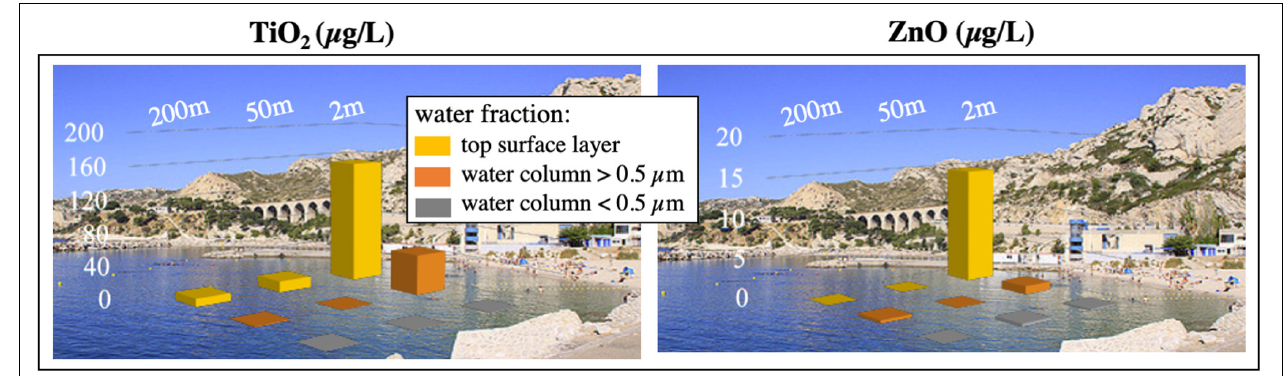
FIGURE 4 | TiO 2 and ZnO concentrations calculated from Ti and Zn elements measurements in marine beach water on the French Mediterranean Coast (La Lave Beach, Marseille), at different distances from the shore line, respectively 2 and 50 m in the bathing zone, and 200 m beyond the bathing zone. Top surface layer and water column were compared. Water column samples were further fractionated by tangential flow filtration in two size classes, > 0.5 µ m and 0.02–0.5 µ m, in order to estimate the aggregation state of the UV-filters (Labille et al., 2020).